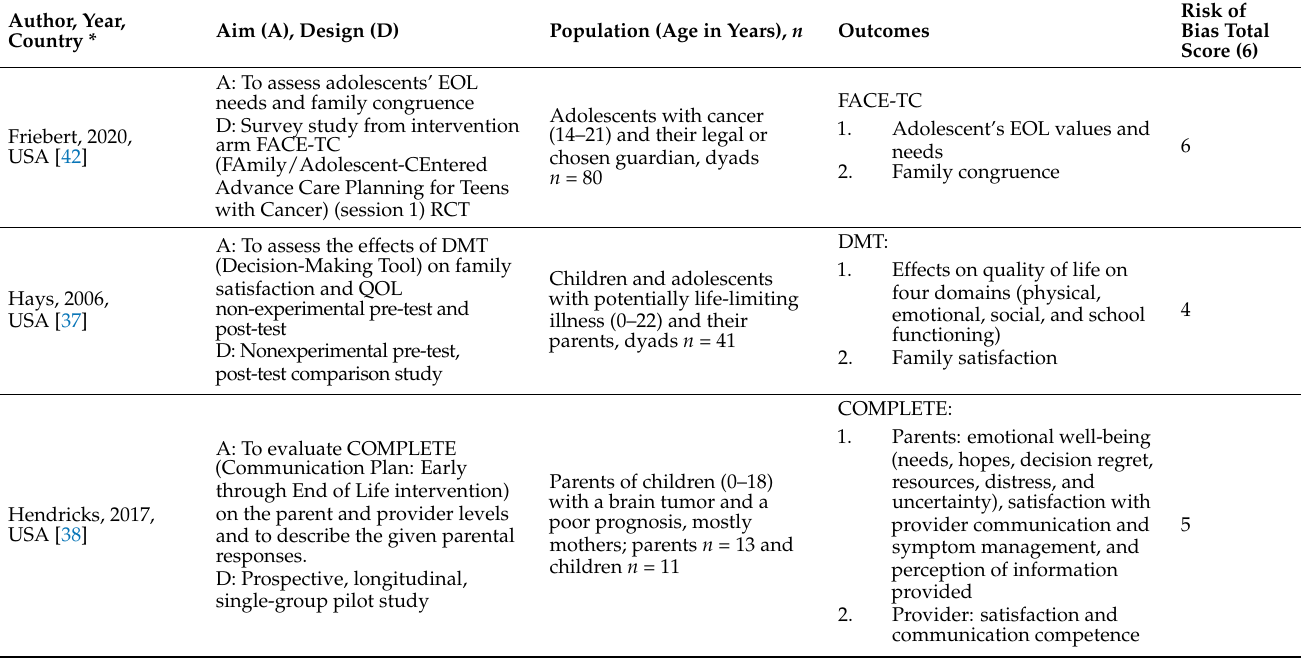
Table 3. Evidence from observational